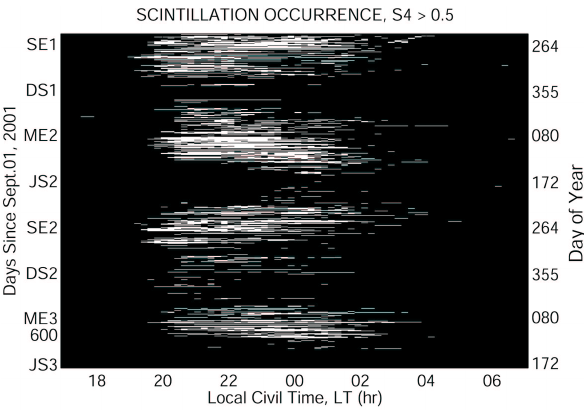
Fig. 5. Daily occurrence record of GPS scintillation with S 4 > 0.5 for a full 22 months to illustrate equinox symmetry. The integer following SE, DS, etc., gives the year, e.g., “SE2” = “September equinox 2002”.